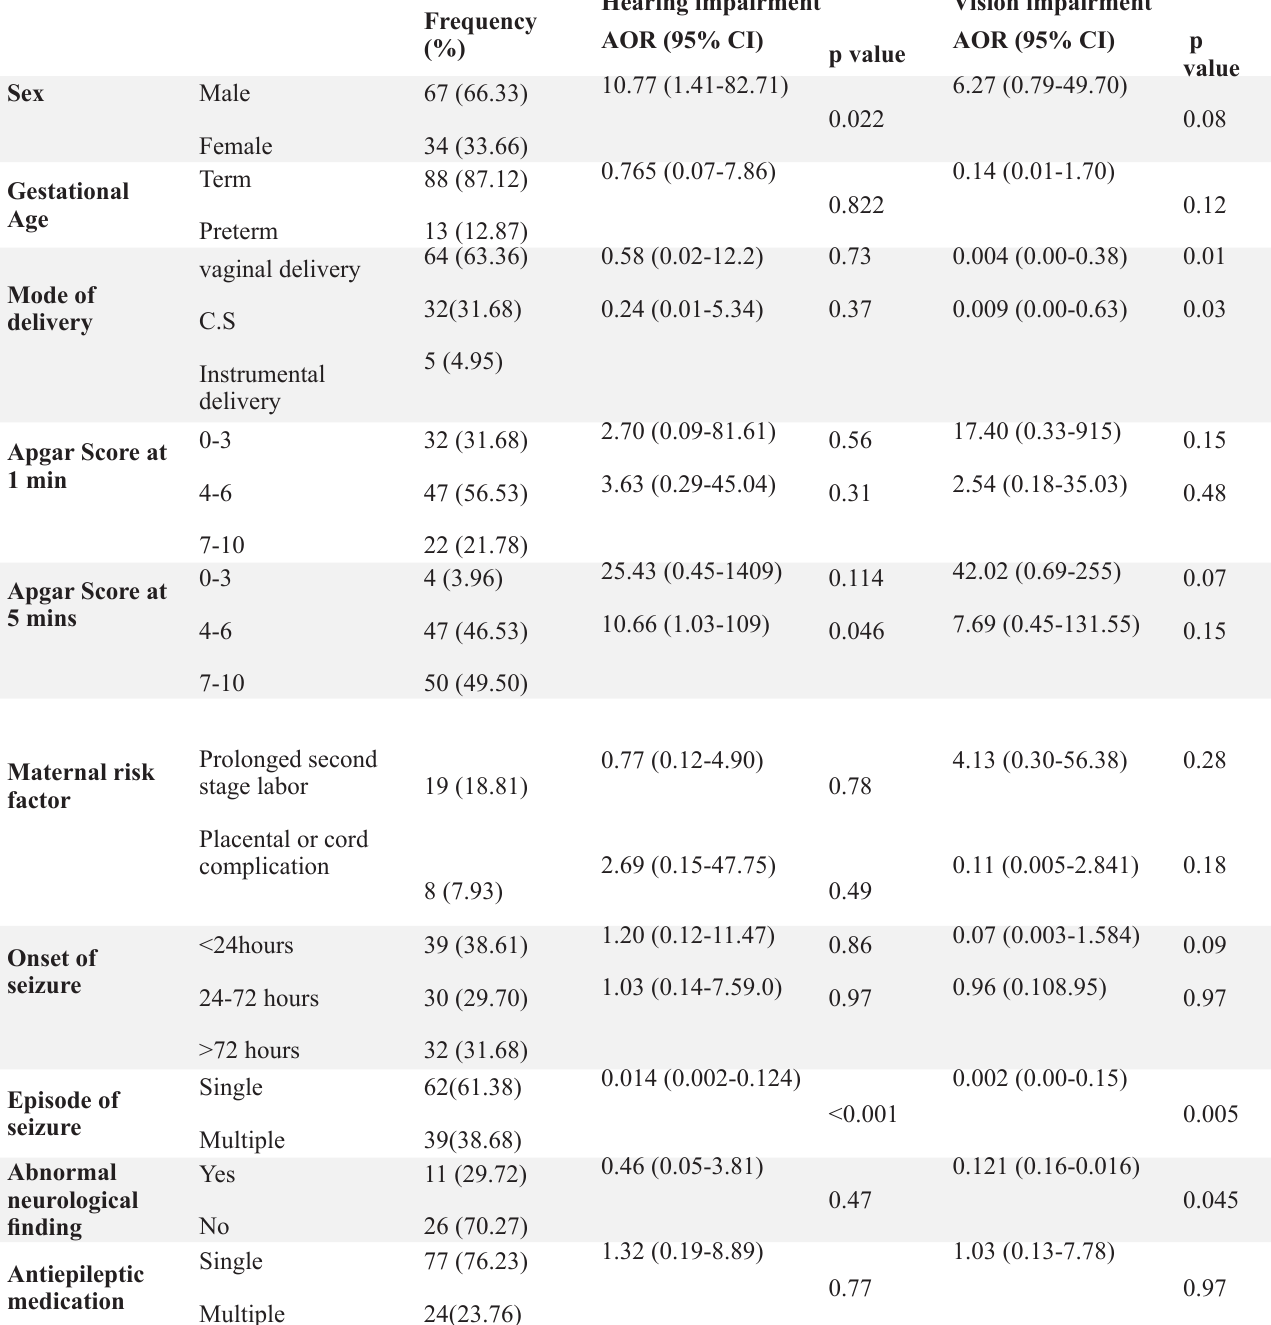
Table 4. Risk factors for vision and hearing impairment (